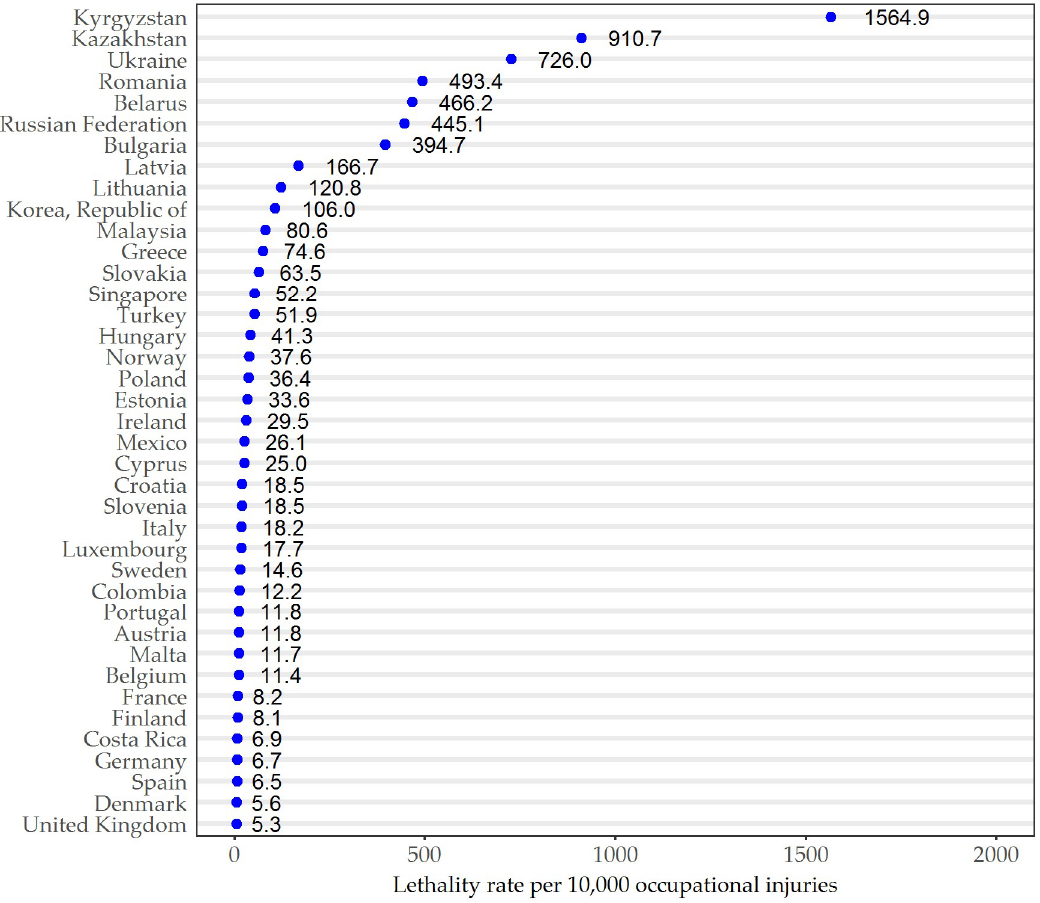
Figure 2. Lethality rate per 10,000 occupational injuries of each country in 2015. Note: All data sourced from International Labour Organization Database (ILOSTAT) [18].